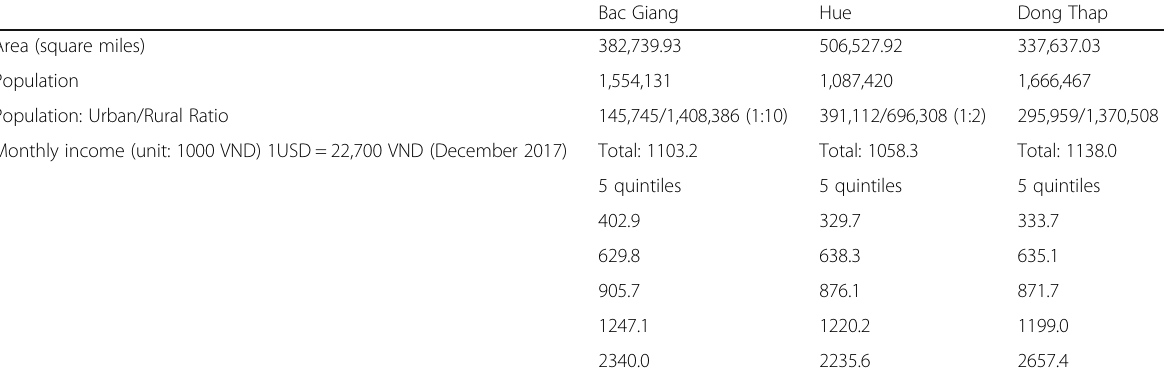
Table 1 Demographic information on sample provinces [17,